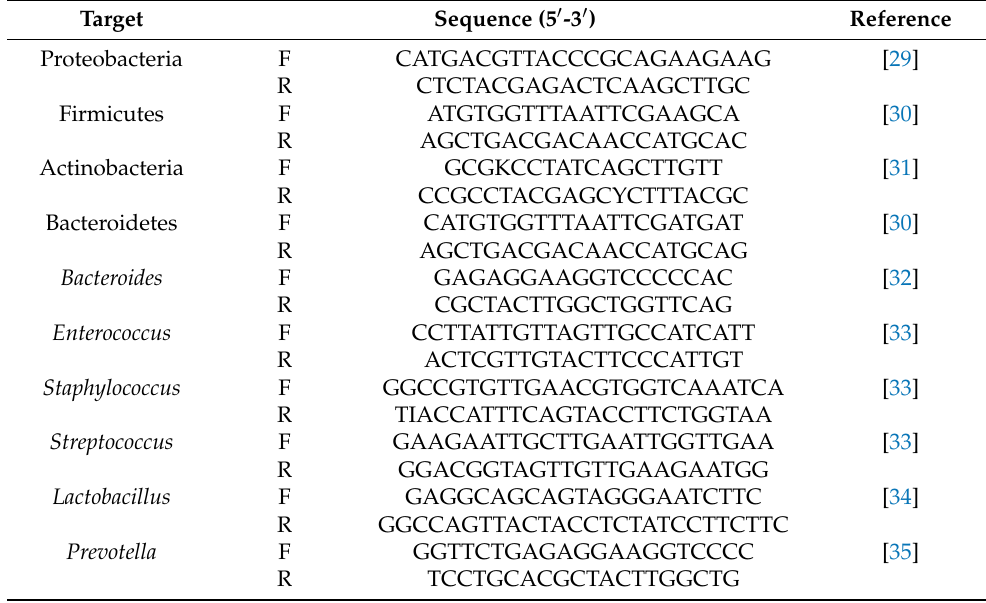
Table 1. List of primers used for qPCR determination of breast milk microbiota.